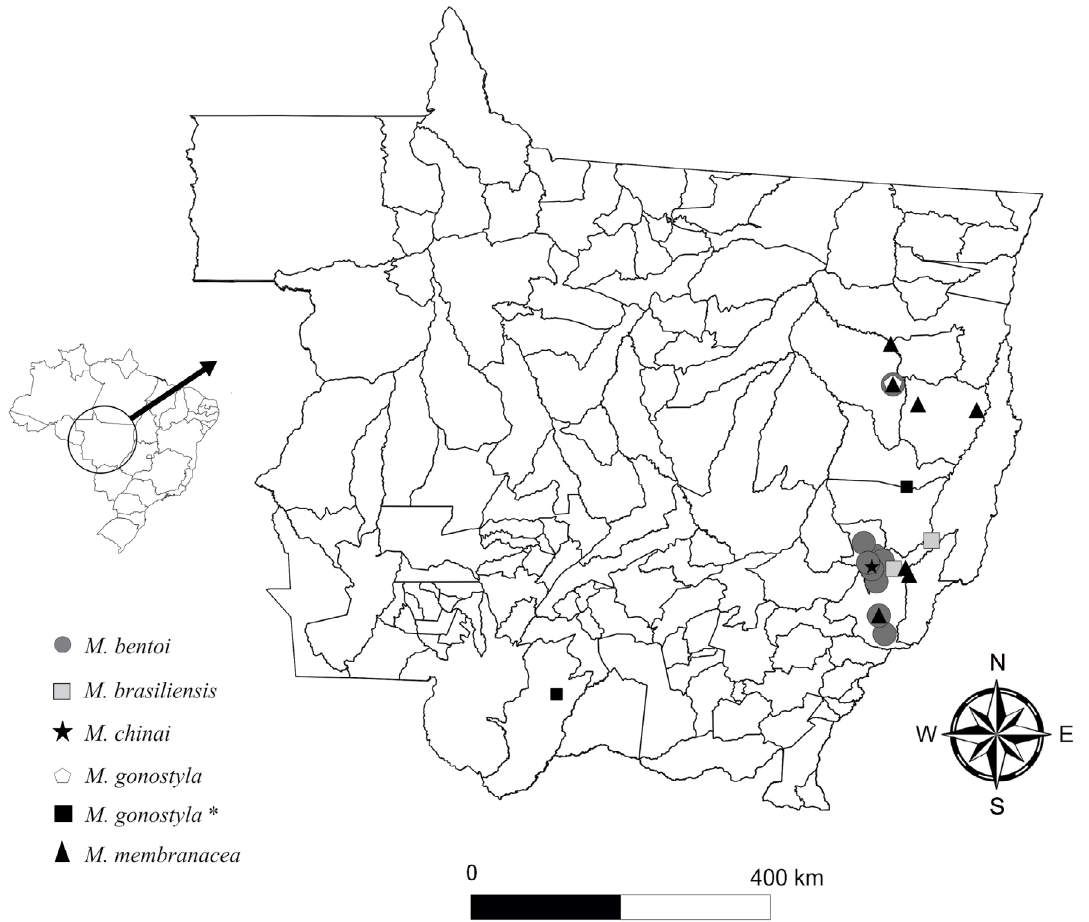
Martarega Figure 1. Distributional records of White, 1879 in the State of Mato Grosso. *Records from